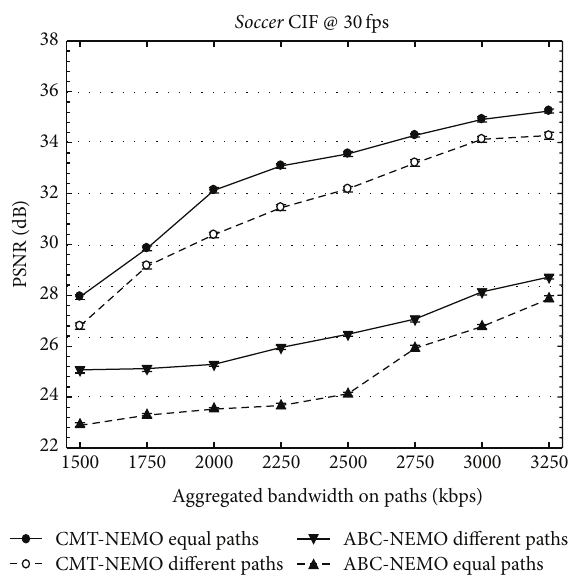
Figure 11: Comparison of schemes for the Soccer sequence at 60fps.